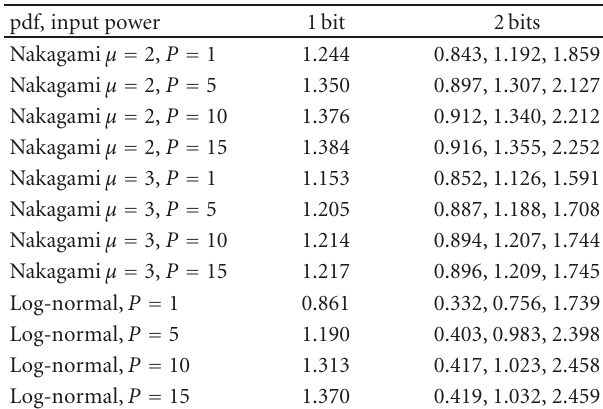
Table 4: Optimal quantization boundaries, reliable quantization region detection, and short-term power